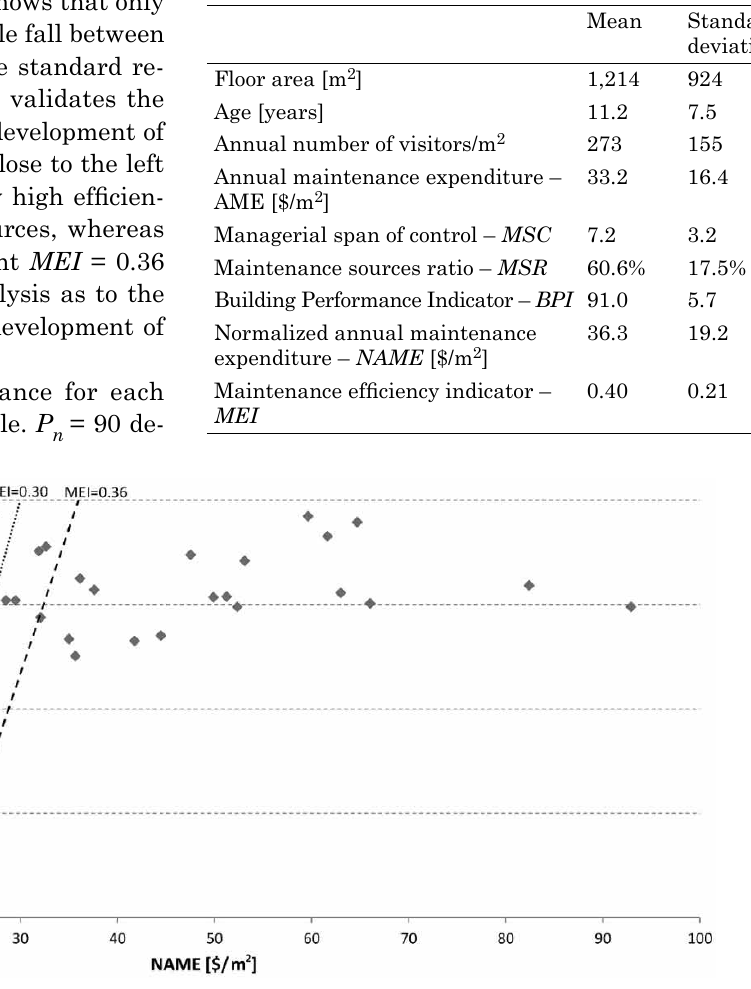
Fig. 4. Building performance indicator against normalized annual maintenance expenditure for the clinic sample